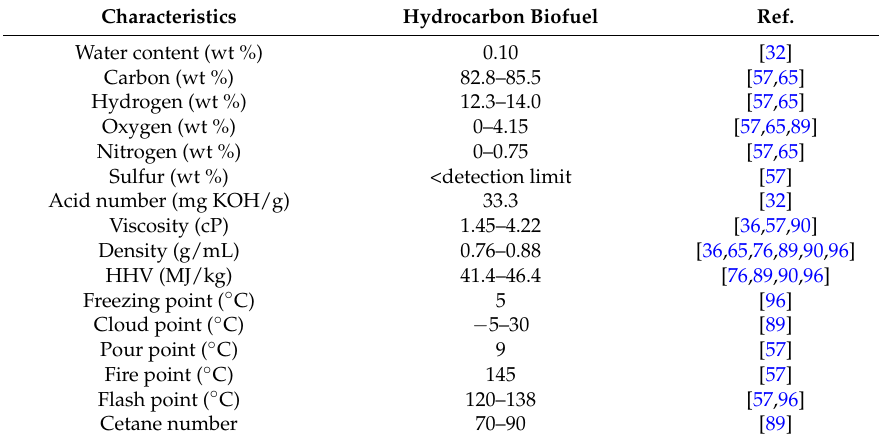
Table 7. Typical properties of hydrocarbon biofuel.